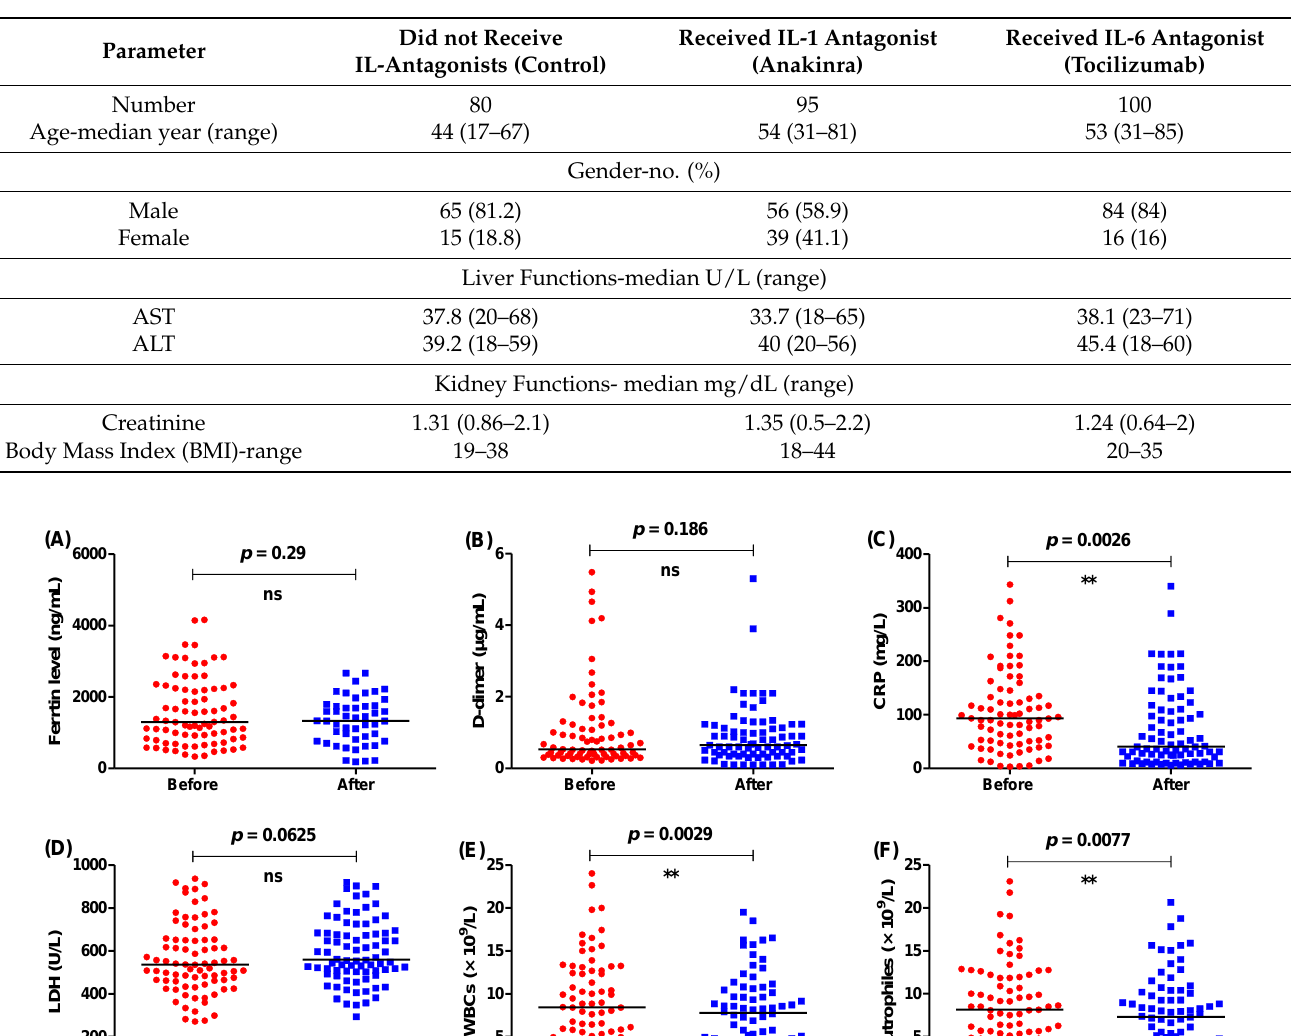
Table 2. Demographic characteristics and clinical features of the cases.